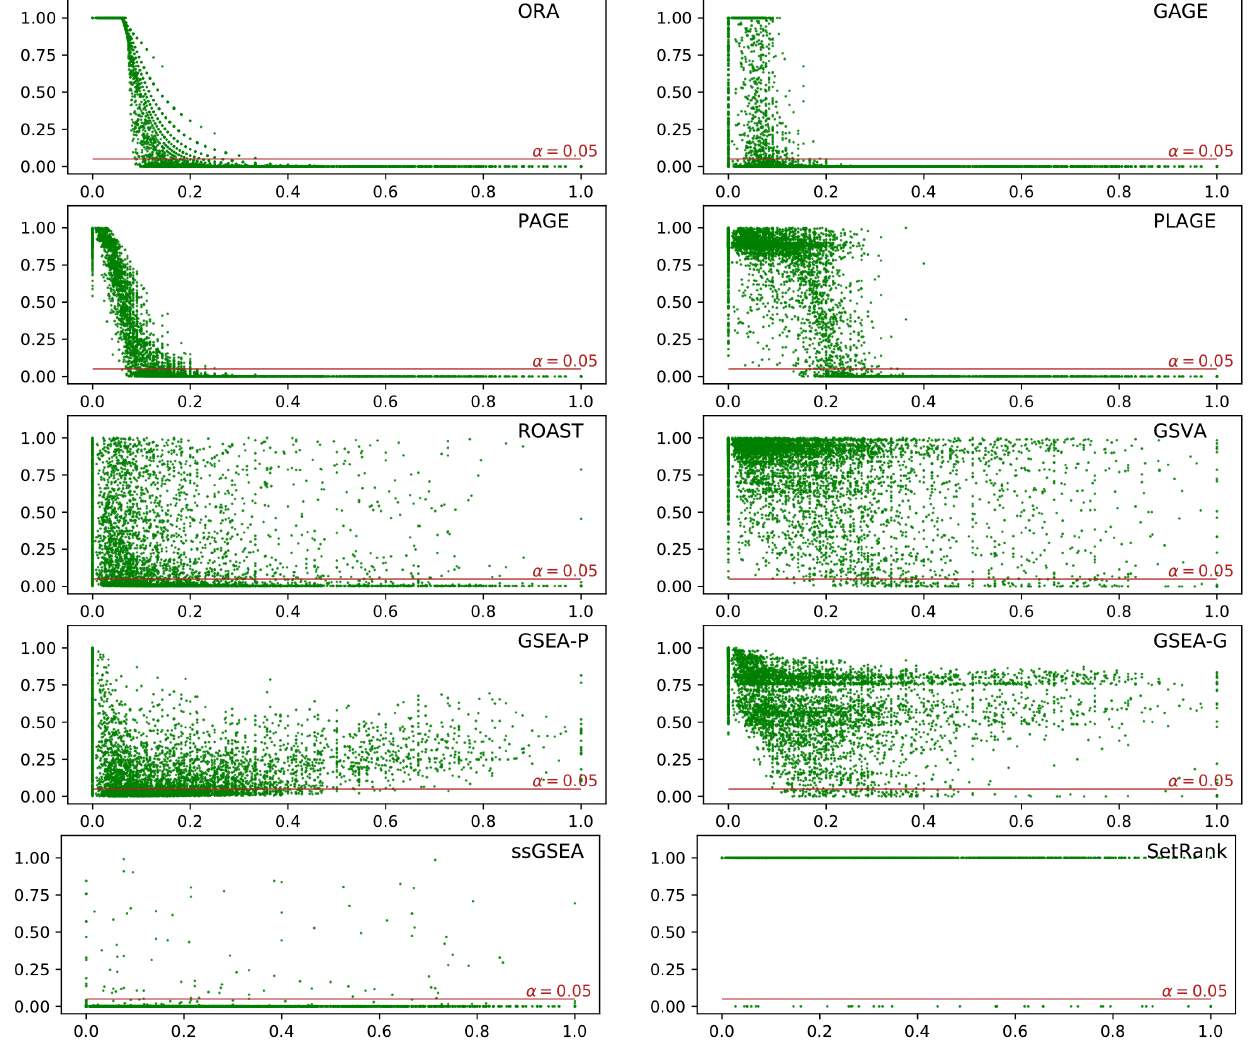
Figure 5. Scatter plots of the relationship between gene set coverage (x-axis) and the statistical significance (adjusted p -value) of the results of each method (y-axis). Each point in green represents a gene set. The red line shows a p -value cutoff of α = 0.05. Since SetRank only returned statistically significant results (points under the red line), we assigned a p -value of 1 to visualize the coverage scores for non-significant results. Note that no cut-off value of γ was applied in any of these scatter